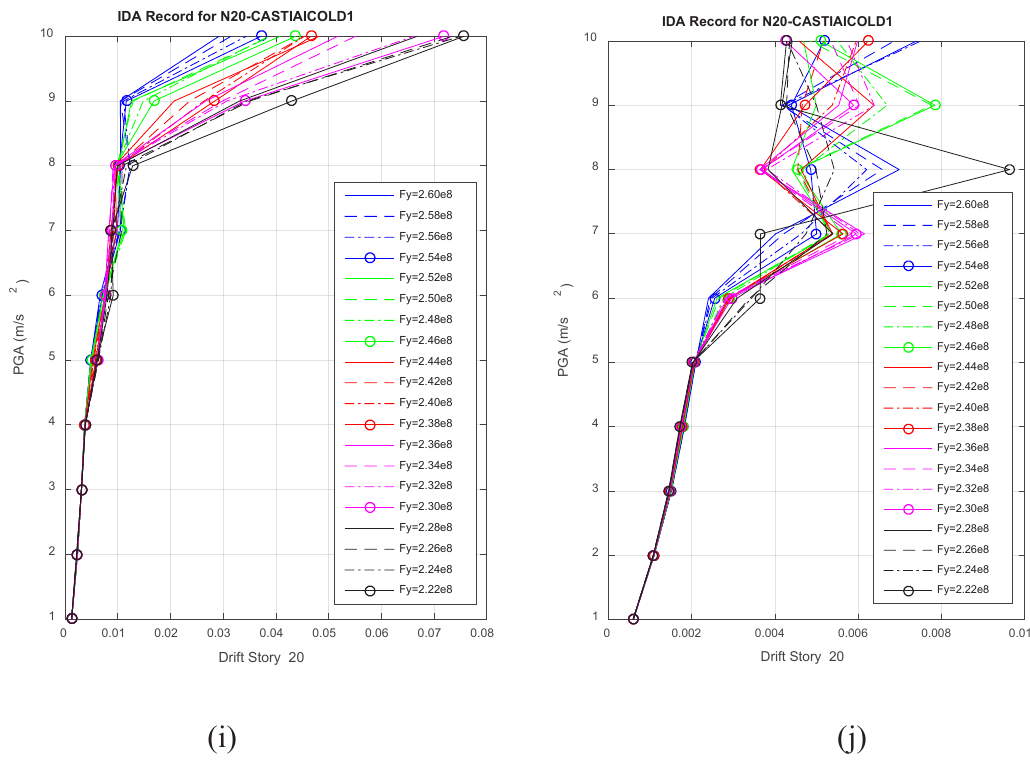
Figure 3. IDA analysis of the (a,b) first, (c,d) fifth, (e,f) tenth, (g,h) fifteenth, and (i,j) twentieth story of the 20-story structure (a,c,e,g,i) not equipped with TMD, and (b,d,f,h,j) equipped with